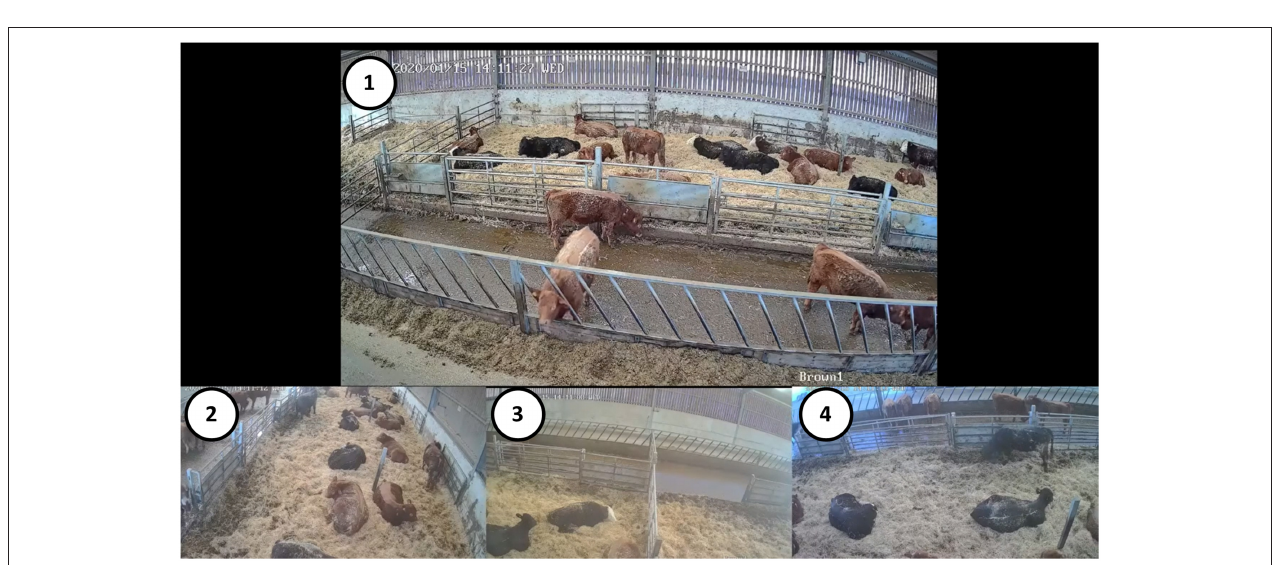
FIGURE 2 | Layout of video collage of the four CCTV cameras installed in each barn, as provided to assessors. Circled numbers have been added for annotation purposes and refer to the cameras from which that video was taken (1–4), as labelled in Figure 1